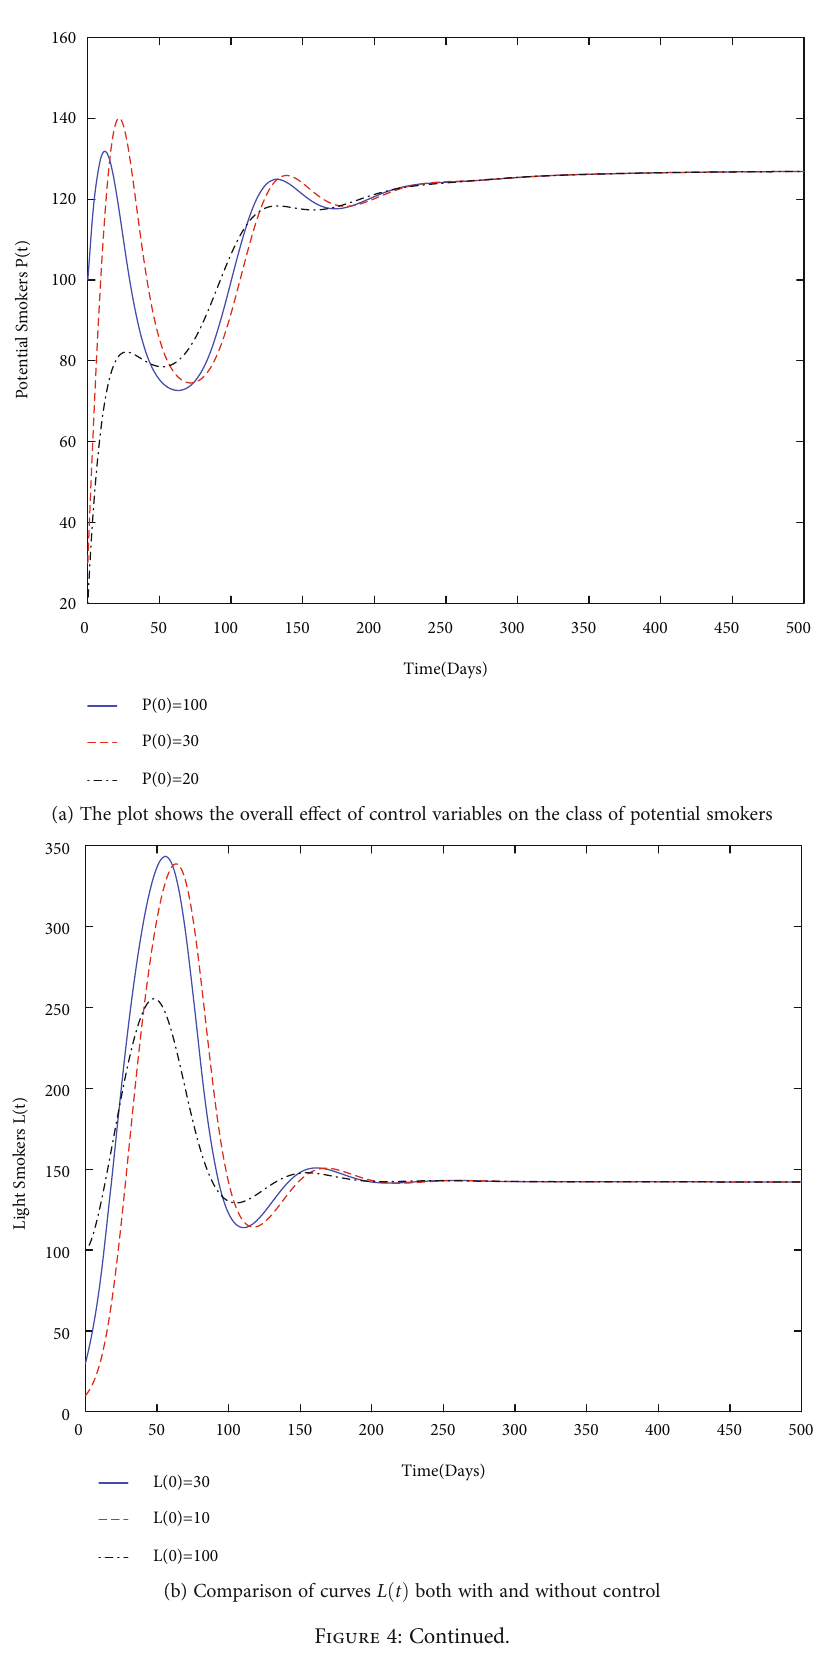
(b) Comparison of curves L ð t Þ both with and without control Figure 4: